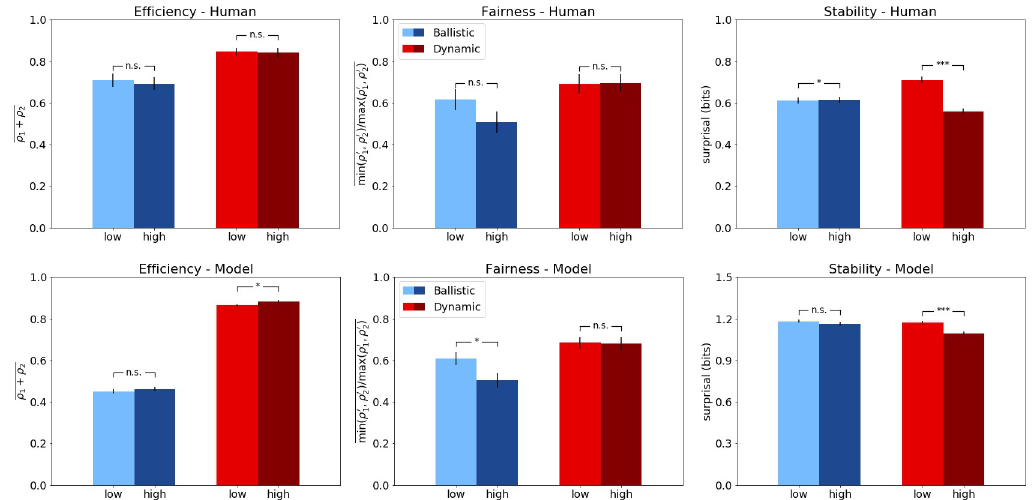
Fig 4. Results of Control-based Reinforcement Learning compared to human performance in the Battle of the Exes game, measured by efficiency (left), fairness (center) and stability (right). The top panel shows the human results obtained in [23]. The bottom panel shows the results of the CRL model. Within each panel, blue bars represent the results in the ballistic condition, and red bars represent the results in the dynamic condition. All error bars reflect standard errors.